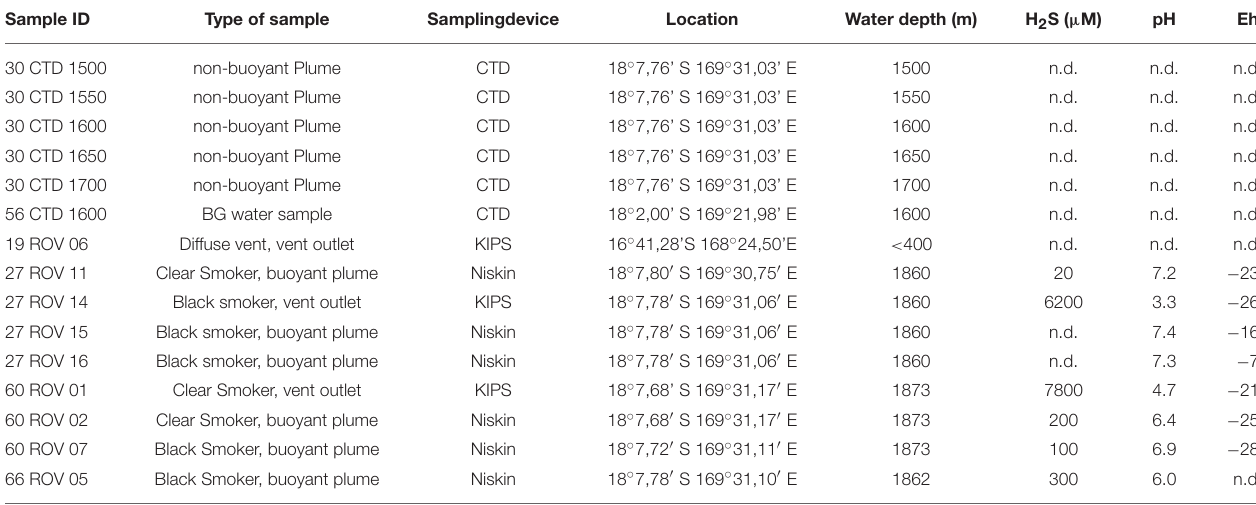
TABLE 1 | Overview on hydrothermal samples taken for Fe speciation. Sample ID